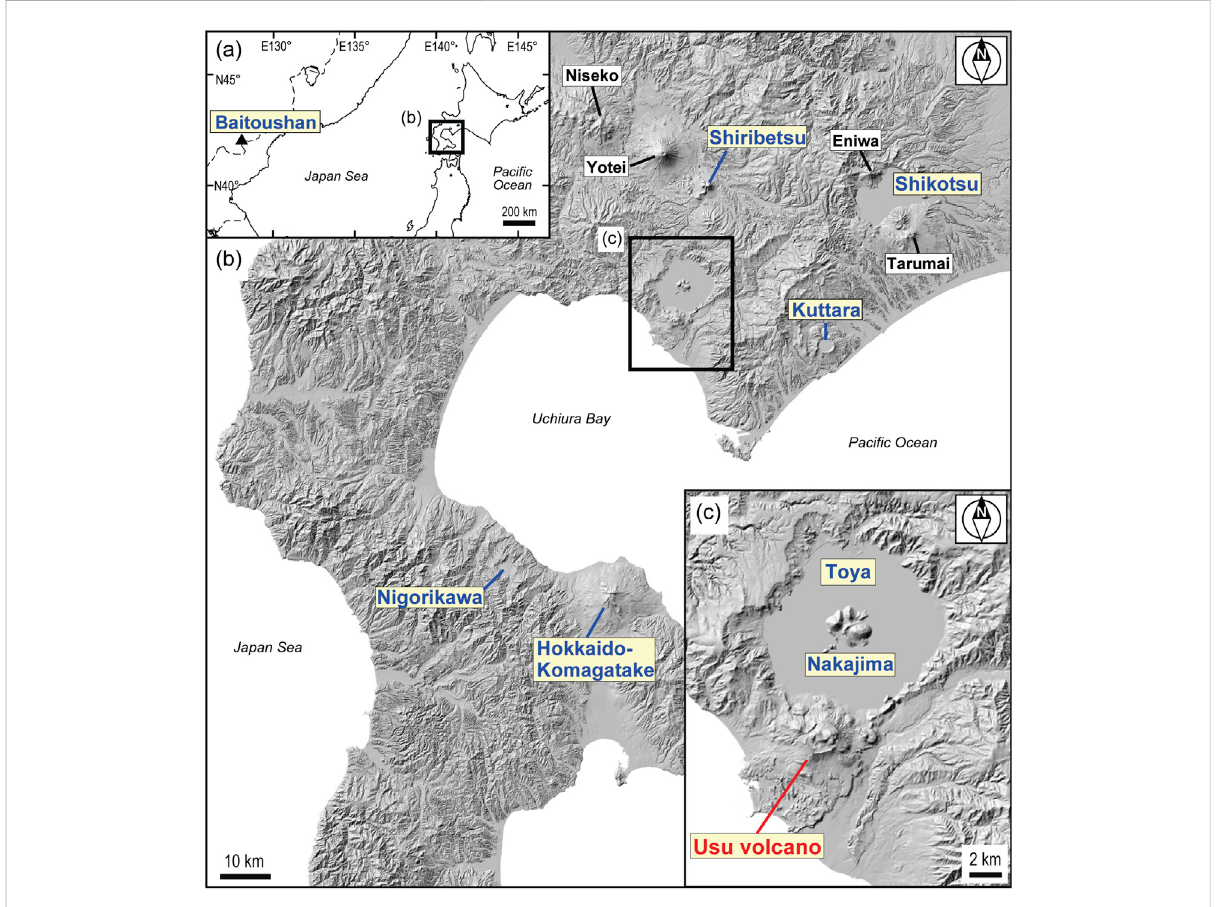
FIGURE 1 Overview map of Usu volcano and nearby volcanoes. Volcanoes in yellow-colored boxes are the source of tephras recognized around Usu volcano. Shaded-relief maps of (B) and (C) were created from digital topographic data provided by Geospatial Information Authority of